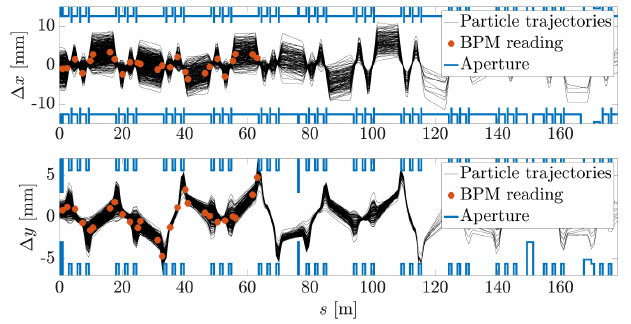
FIG. 11. Plot of the injected beam for a realization of the ALS- U accumulator ring after commissioning of the BTA transfer line, showing the particle trajectories (black), BPM readings (red), and aperture (blue) for 400 particles within the first turn.